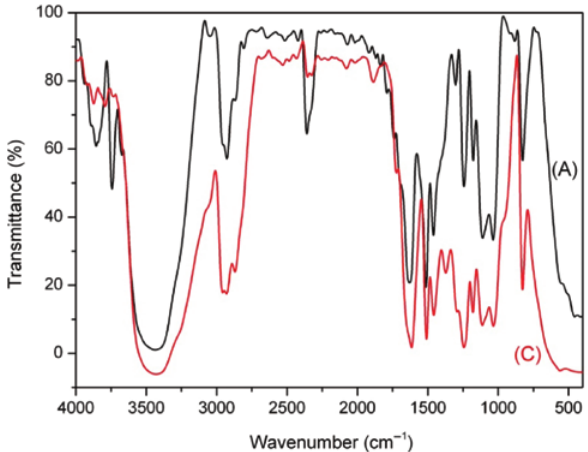
Figure 6: The IR spectrum of the epoxy resin before (A) and after 2 h of neutron irradiation (C) in the TRR reactor core.